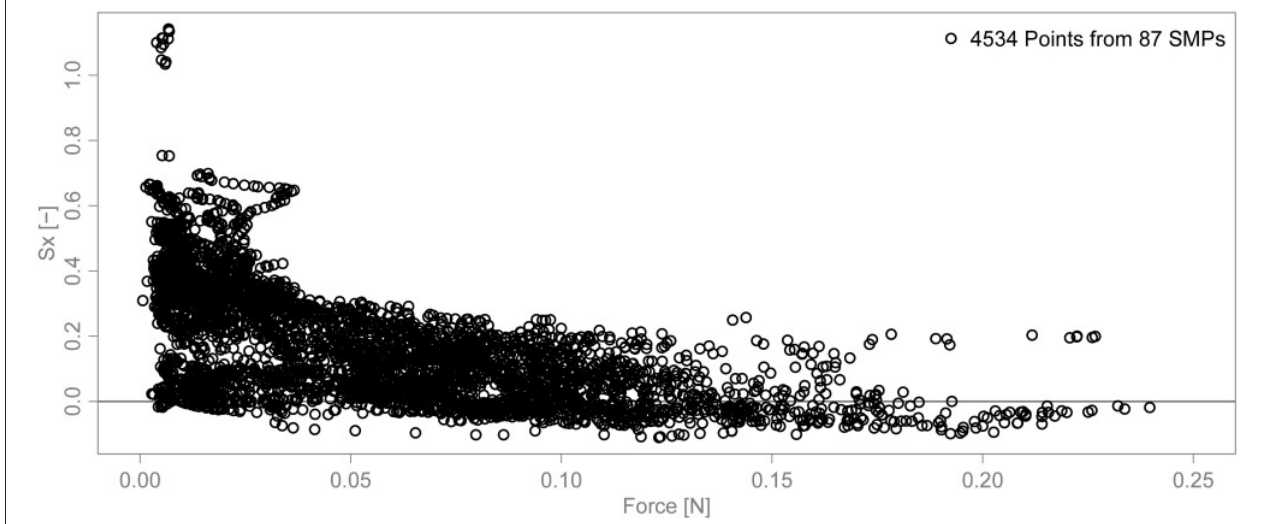
FIGURE 9 | Scatterplot of Sx against the SMP force showing the effect of wind-exposure on wind-packing. The plot is the same as Figure 8D but shows 4,534 points from 87 SMPs.